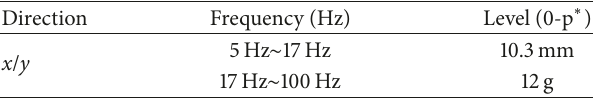
Table 1: Sinusoidal vibration experimental conditions.